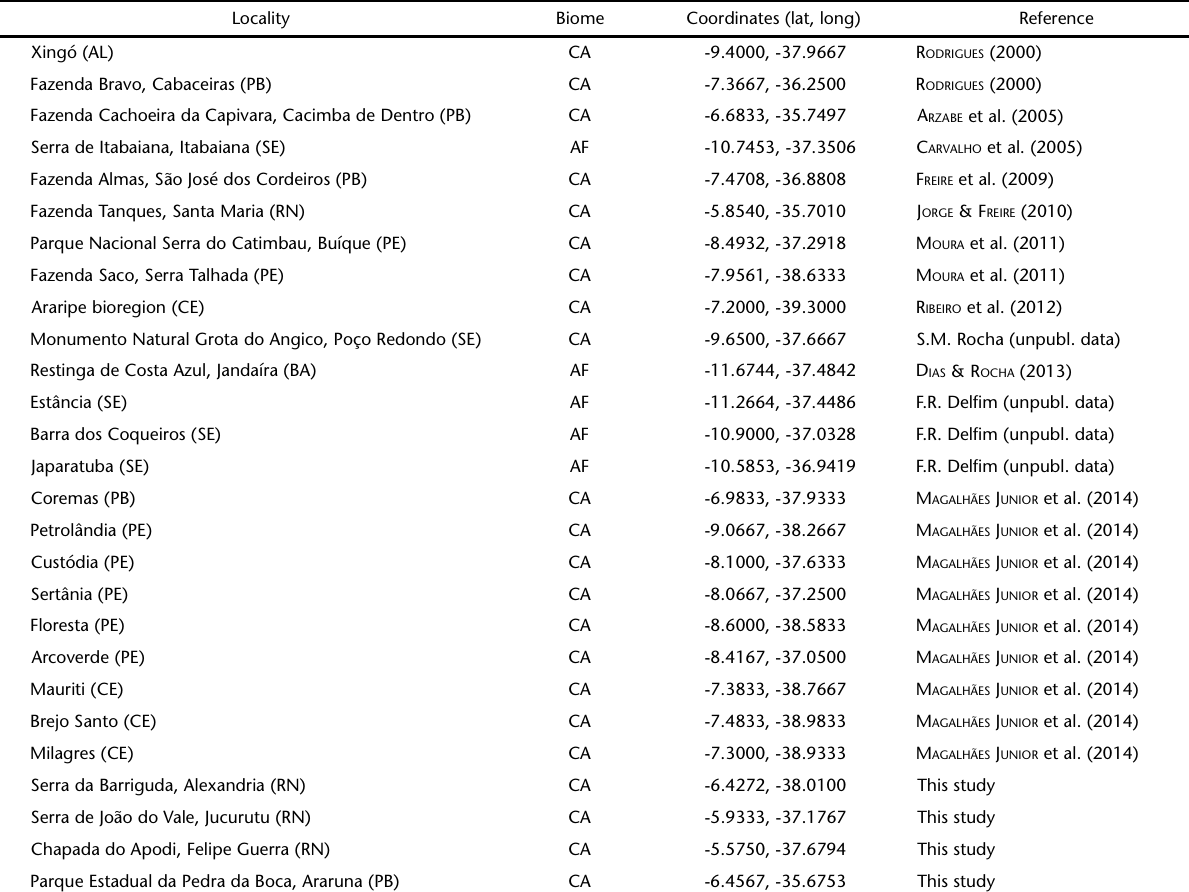
Table I. Localities and coordinates (in decimals) used in the distribution model for Mabuya agmosticha , including the new records. States: (AL) Alagoas, (BA) Bahia, (CE) Ceará, (PB) Paraíba, (PE) Pernambuco, (RN) Rio Grande do Norte, (SE) Sergipe. Biomes: (CA) Caatinga, (AF) Atlantic